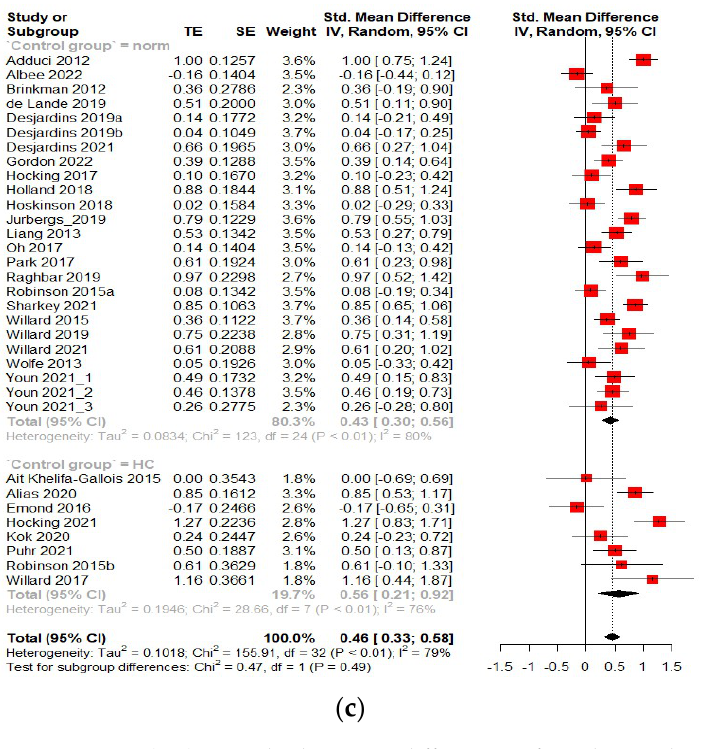
Figure 3. ( a – c ) Standard mean difference of pediatric brain tumor survivors having neurobehavioral impairment compared to the population norm and healthy controls. Youn et al. (2021) [83] reported more than one independent cohort in their study. HC: healthy control [35–48,50–58,61,62,65–72,75–78,80–83]. ( a ) Standard mean difference—attention problems; ( b ) Standard mean difference—emotional difficulties; ( c ) Standard mean difference —psychosocial